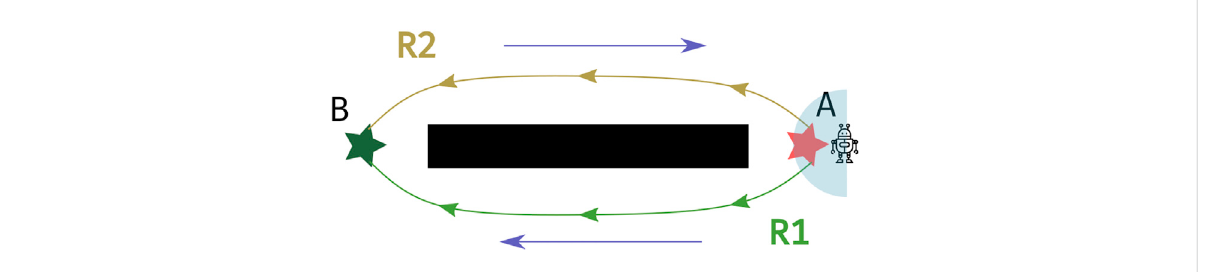
FIGURE 1 Two corridors on either side of a large central obstacle (black wall). Blue arrows indicate the typical direction of motion of dynamic entities. R1 and R2 are possible paths of equal length that can be taken by a robot to go from A (red star) to B (green star). When equipped with information about the typical patterns of motion via a Map of Dynamics (MoD), the robot will choose R1, the path that conforms with the blue